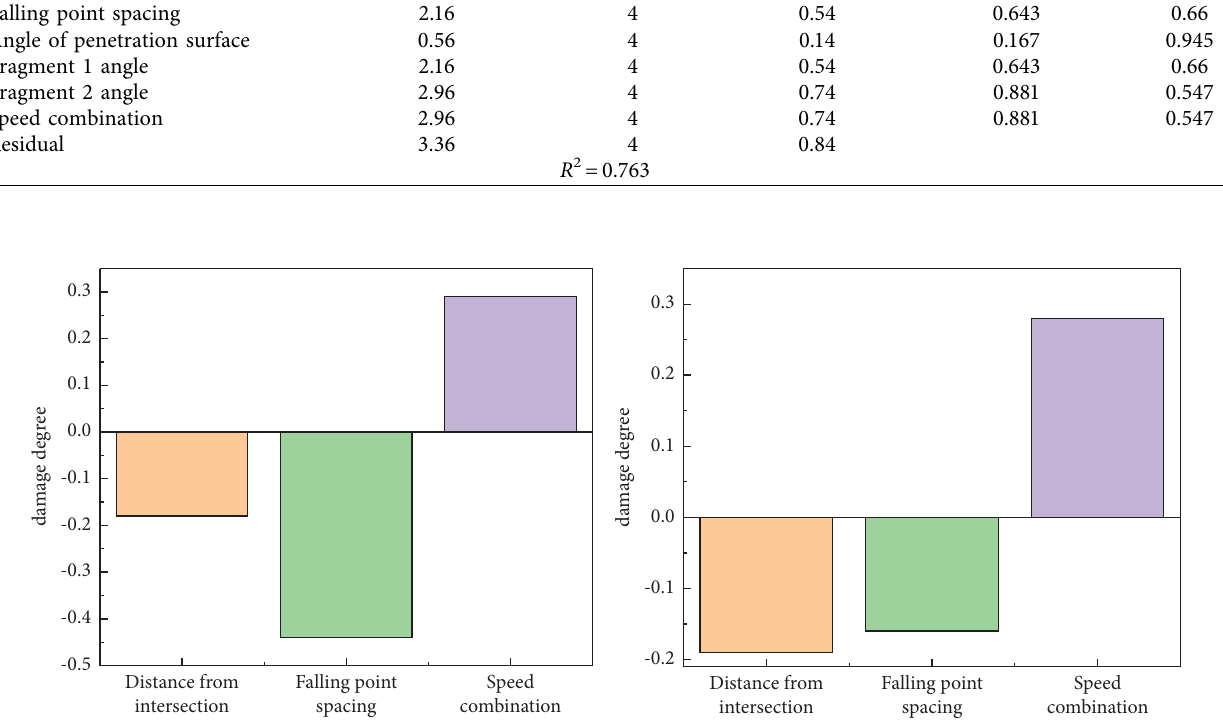
Figure 18: Standardized regression coefcients of optimized variables for two joint damage degrees.